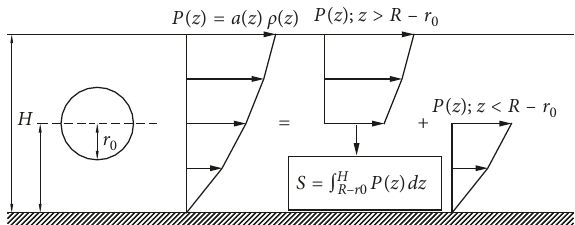
Figure 5: Method employed to apply a seismic